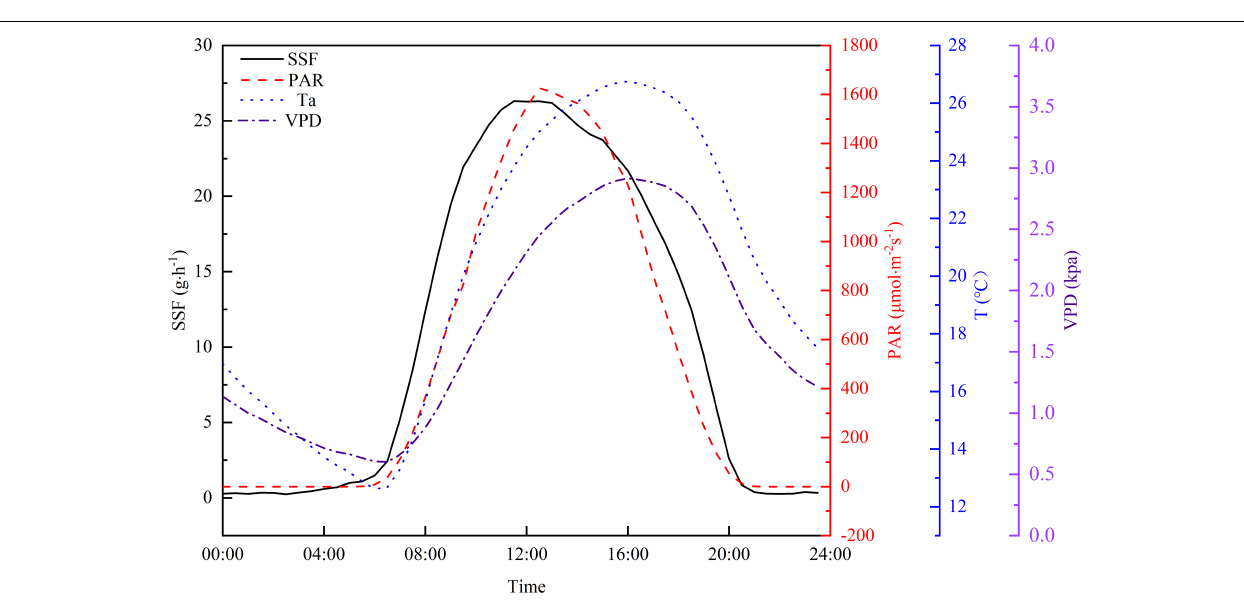
day, indicating that variations in PAR, Ta, and VPD lagged behind those in the